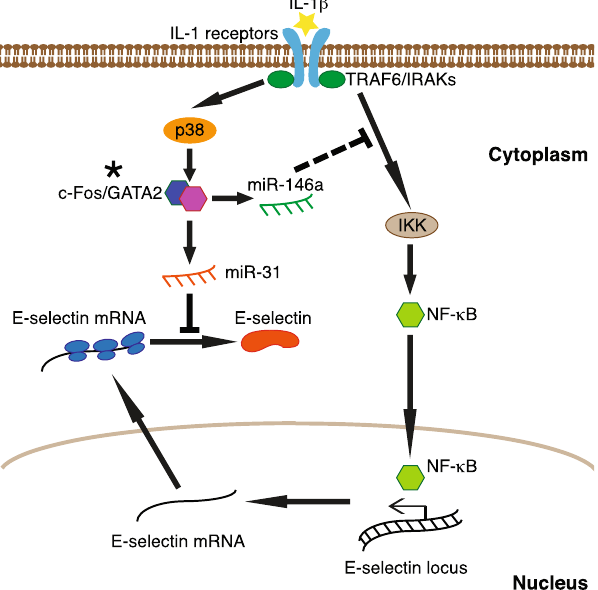
Figure 7. p38 mediates the transcription and the translation of E-selectin by modulating miR-146a and miR-31. Following stimulation with IL-1 β , the receptor-adaptor complex signals through NF- κ B pathway to activate the transcription of E-selectin. In parallel, the complex also signals through p38 pathway to induce the production of miR-146a and miR-31. The former, in a feedback loop, targets adaptor proteins TRAF6 and IRAKs to repress NF- κ B-dependent E-selectin expression at the transcriptional level. The latter targets E-selectin mRNA to inhibit its translation. * In order to simplify the figure, the transcription of miRNAs is presented in the